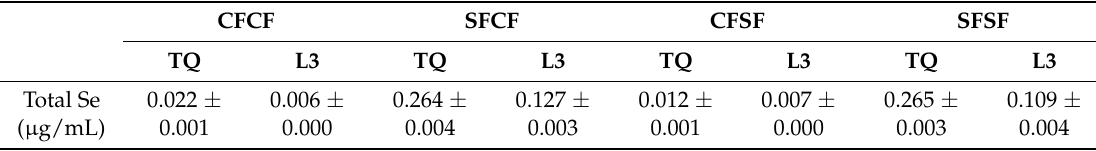
Table 2. Total Selenium (Se) content in gastro-intestinal (GI) hydrolysates. CFCF SFCF CFSF SFSF TQ L3